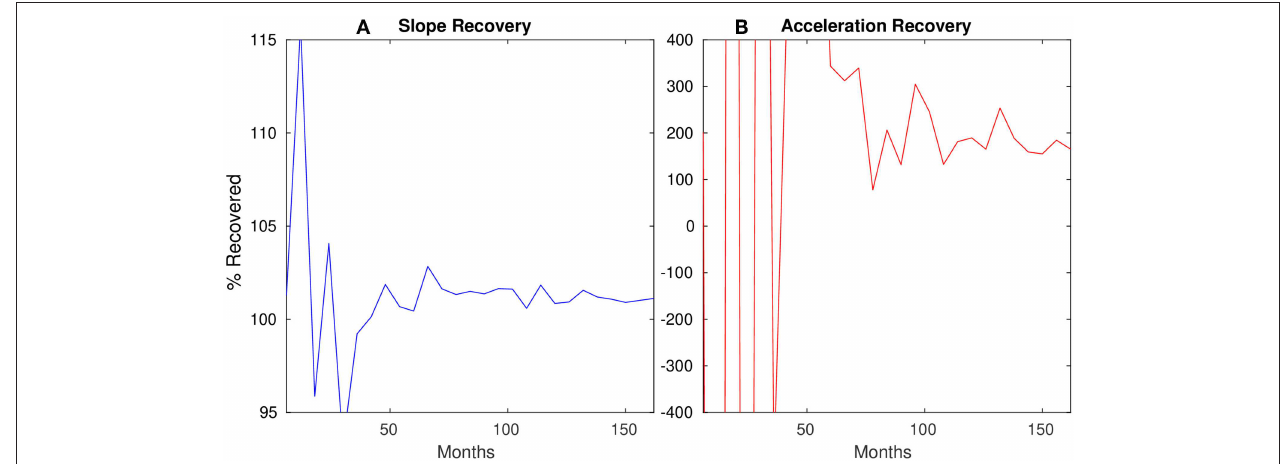
FIGURE 6 | Results of our synthetic experiment for Iceland to test recovery of (A) slope and (B) acceleration parameters. For varying amounts of months of consistent synthetic data over Iceland we use our Slepian method to measure the slope and acceleration of the mass loss trend. The x -axis denotes the number of cumulative months of synthetic data processed, and the y -axis denotes the 100 ∗ R A , where R is the recovered slope or acceleration and A is the applied synthetic slope or